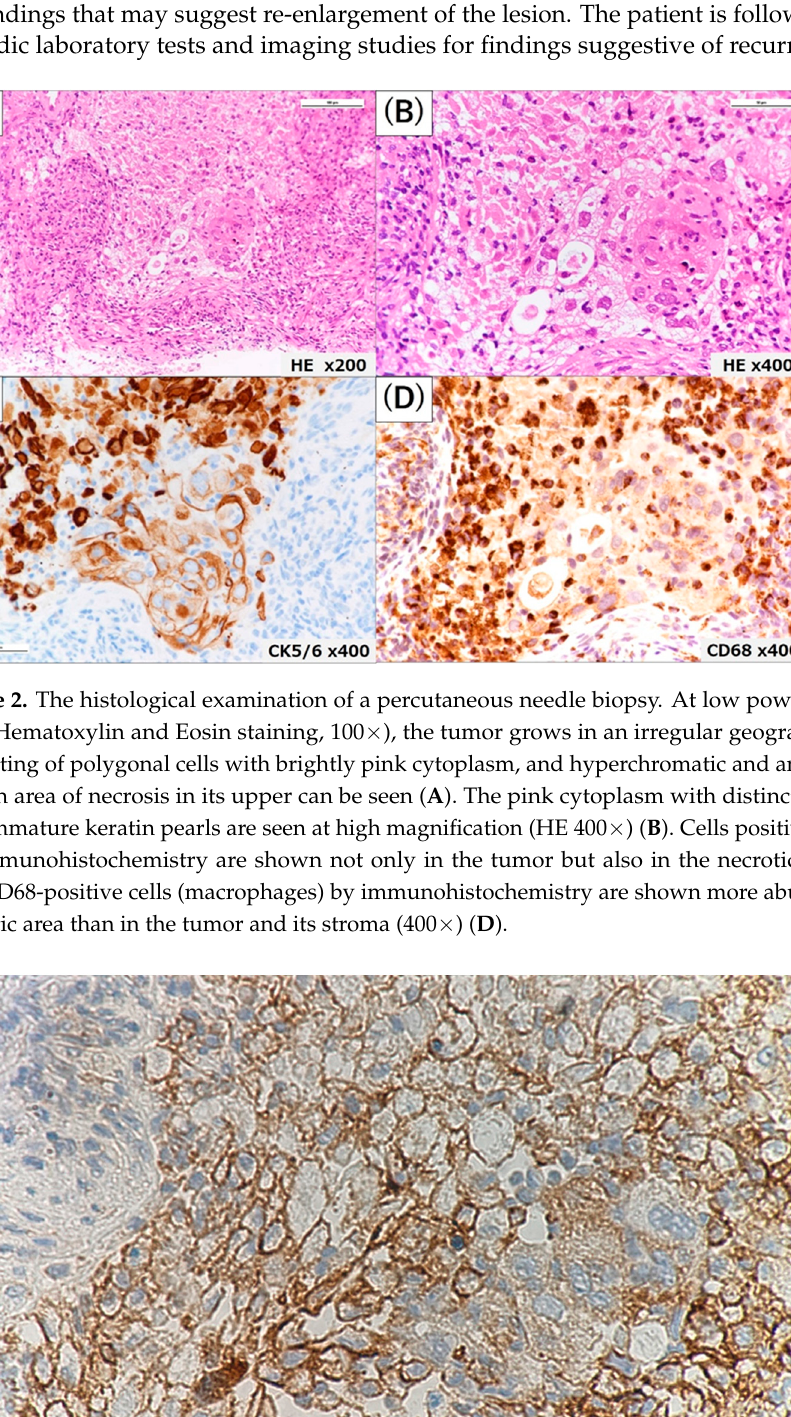
Figure 3. The immunohistochemistry using anti-PD-L1 clone 22C3 that targets the extracellular domain of PD-L1 (400×). Cells positive for PD-L1 are shown not only in the tumor but also in the necrotic area. PD-L1: programmed death-ligand 1.